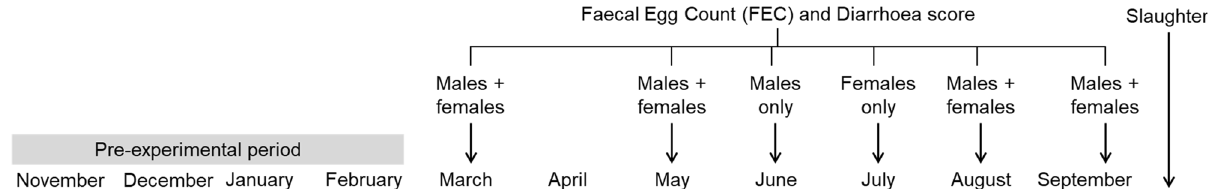
Figure 1. Schema of the experimental protocol, showing timing of measurements (FEC and diarrhoea score sheep) from March (autumn) through to September (spring). For the 4-month pre-experimental period leading up the first measurement, the pasture was not used for grazing to avoid contamination with helminth eggs. In this environment, helminth infection is usually associated with the onset of winter rains in From November 2016 until September 2017, the lambs were kept in single-sex flocks in two fields, but other- wise managed similarly, where they grazed an annual grass clover pasture with capeweed ( Arctotheca calendula ). The stocking rate was kept at 10 lambs per hectare. The pasture had not been grazed for 4 months before the experiment began in March 2017, allowing the lambs to acquire a natural helminth infection under natural conditions. The pastures were kept green by unusual rain in February and subsequent rainfalls (in March, April and May), so the sheep had access to green fodder throughout the experiment, from February until the end in September, in contrast to normal season when green fodder does not become available until May. The domi- nant parasite species at the start of experiment were Teladorsagia spp., then Trichostrongylus spp., followed by Chabertia ovina and Oesophagostomum venulosum , and a small fraction of Haemonchus contortus . This species composition changed by the end of experiment as Trichostrongylus spp. became dominant, followed by C. ovina , O . venulosum , Teladorsagia spp. and a small fraction of H. contortus 39 . In March, May June, August, and September (Fig. 1), all 200 lambs were scored for diarrhoea, using a scale of 1 to 5 (low to high) based on the amount of faecal material accumulated on the hind quarters, between the anus